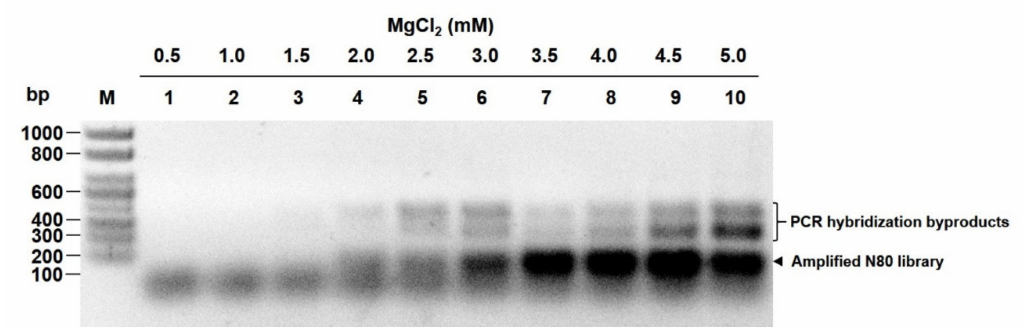
Figure 3. Optimization of MgCl 2 concentration for e ffi cient emulsification PCR (ePCR). Purified DNA from ePCR with gradient MgCl 2 concentrations in lanes 1–10: 0.5, 1, 1.5, 2, 2.5, 3, 3.5, 4, 4.5 and 5 mM,